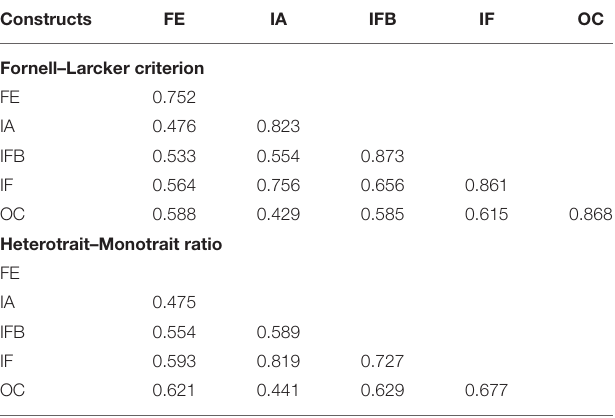
TABLE 3 | Discriminant